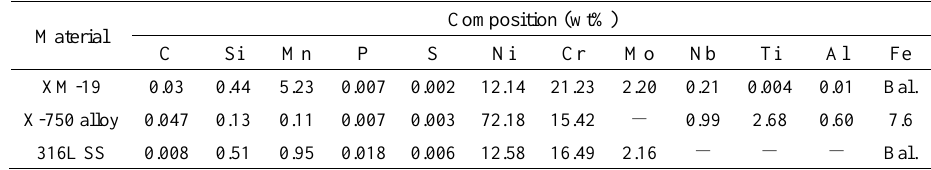
Table 1. Composition of specimens.